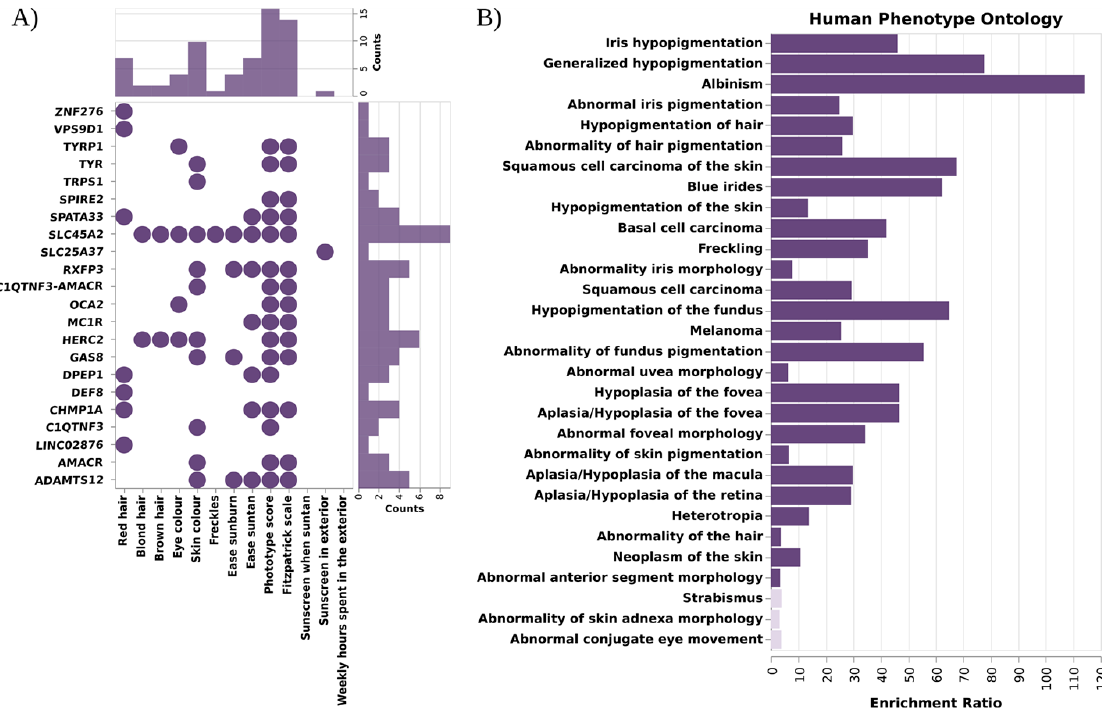
Figure 3. Results of the gene-based analysis and functional enrichment. ( A ) Scheme depicting the total count of associations (dots) per gene (bottom bar plot) and trait (right-hand bar plot) identified by gene-based analysis with MAGMA software. SLC45A2 was the most pleiotropic gene, being associated with 9 pigmentary traits; on the other hand, phototype traits were the ones with more associated genes ( B ) Functional enrichment analysis of the 22 aggregated genes with WebGestalt. Bar plot depicting enrichment ratio in the X axis, and the different Human Phenotype Ontologies in the Y axis. Dark color indicates that pass the FDR threshold. Pigmentary traits and diseases are significantly enriched in these